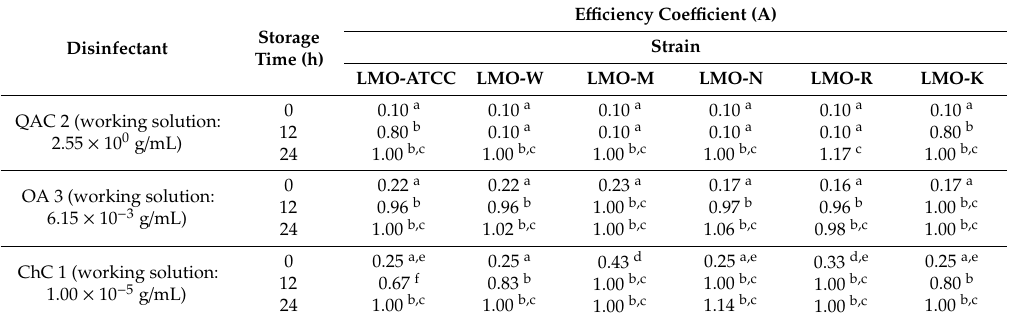
Table 7. E ffi ciency coe ffi cient values for tested strains and disinfectants after storage of solutions. E ffi ciency Coe ffi cient (A) Storage Strain Disinfectant Time (h) LMO-ATCC LMO-W LMO-M LMO-N LMO-R LMO-K 0.10 a 0 QAC 2 (working solution: 12 0.80 b 2.55 × 10 0 g / mL) 24 OA 3 (working solution: 6.15 × 10 − 3 g / mL) 0 0.25 a,e ChC 1 (working solution: 12 0.67 f 1.00 × 10 − 5 g / mL) 24 QAC 2—benzyl-C12-16 alkyldimethyl chlorides; OA 3—peracetic acid, hydrogen peroxide bis (sulphate) bis (peroxymonosulfate); ChC 1—chlorine dioxide; LMO-ATCC— L. monocytogenes ATCC 19111,